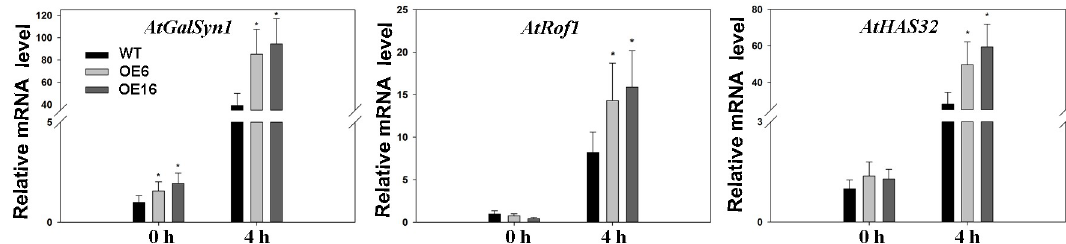
Figure 10. Relative mRNA expression levels of other heat protection genes. OE6 and OE16 were selected to be tested in thermal environment (37 °C) and leaf samples were collected at 0 and 4 h after heat stress. Values were means ± SD of three different biological replications (with two technical replications for each biological replication). Asterisks indicated significant differences between means of WT and transgenic lines at each time period according to Fisher’s protected LSD test ( p < 0.05).